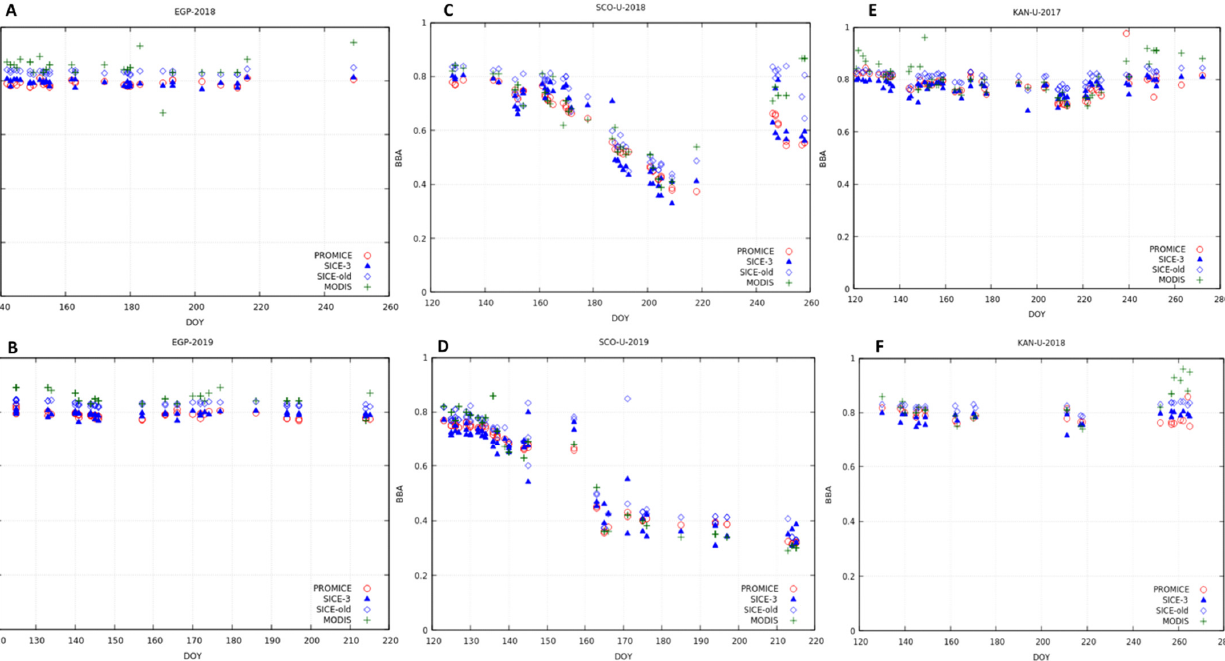
Figure 5. The intercomparison of BBA measured at PROMICE AWS (( A , B ): EGP, ( C , D ): SCO-U, ( E , F ): KAN-U) and derived using the present algorithm (SICE-3) for different years (upper panel—2018, lower panel—2019). The values of the broadband albedo derived from MODIS observations and previous version of the algorithm (SICE-old) are also shown.